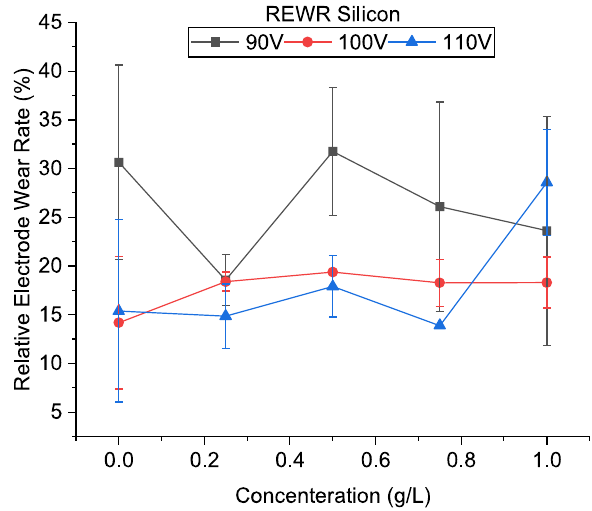
Figure 20. Relative electrode wear rate using silicon-mixed